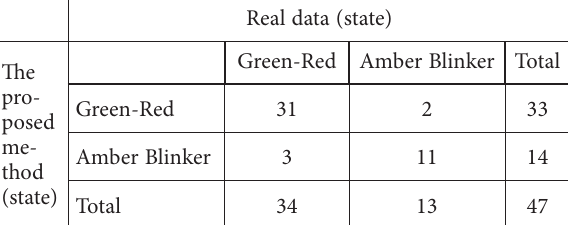
Table 1. The comparison of traffic signal location between proposed method and the real once Real data (Location) Traffic signal The pro- posed me- thod (Lo ca- tion) Table 2. The comparison of traffic signal state between proposed method and the real once Real data (state) Green-Red Amber Blinker Total The pro- Green-Red posed me- Amber thod (state)